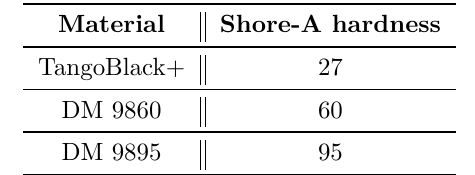
Table 1. Non-magnetoactive materials used for O-rings